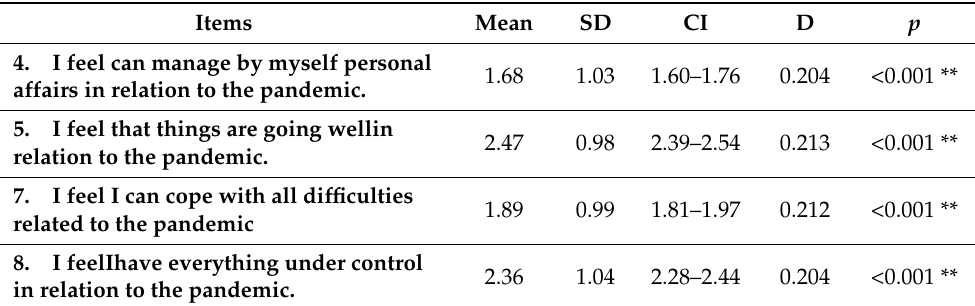
Table 4. Items related to positive perceptions reported by respondents during the ‘third wave’ of the COVID-19 pandemic in Spain.